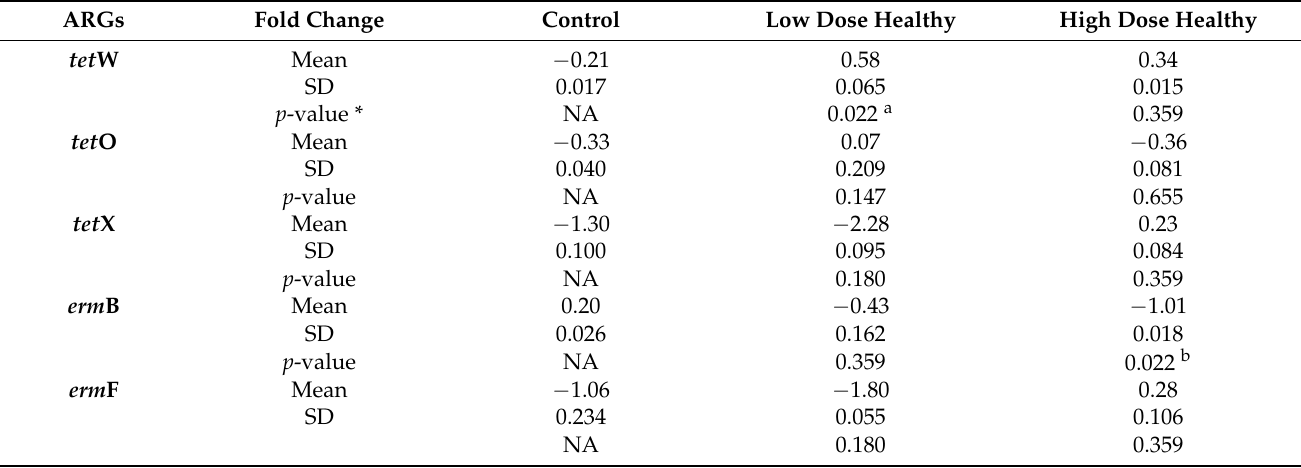
Table 9. Quantitative PCR results for five antimicrobial resistance determinants in three groups of calves, log 2 transformed mean and standard deviation